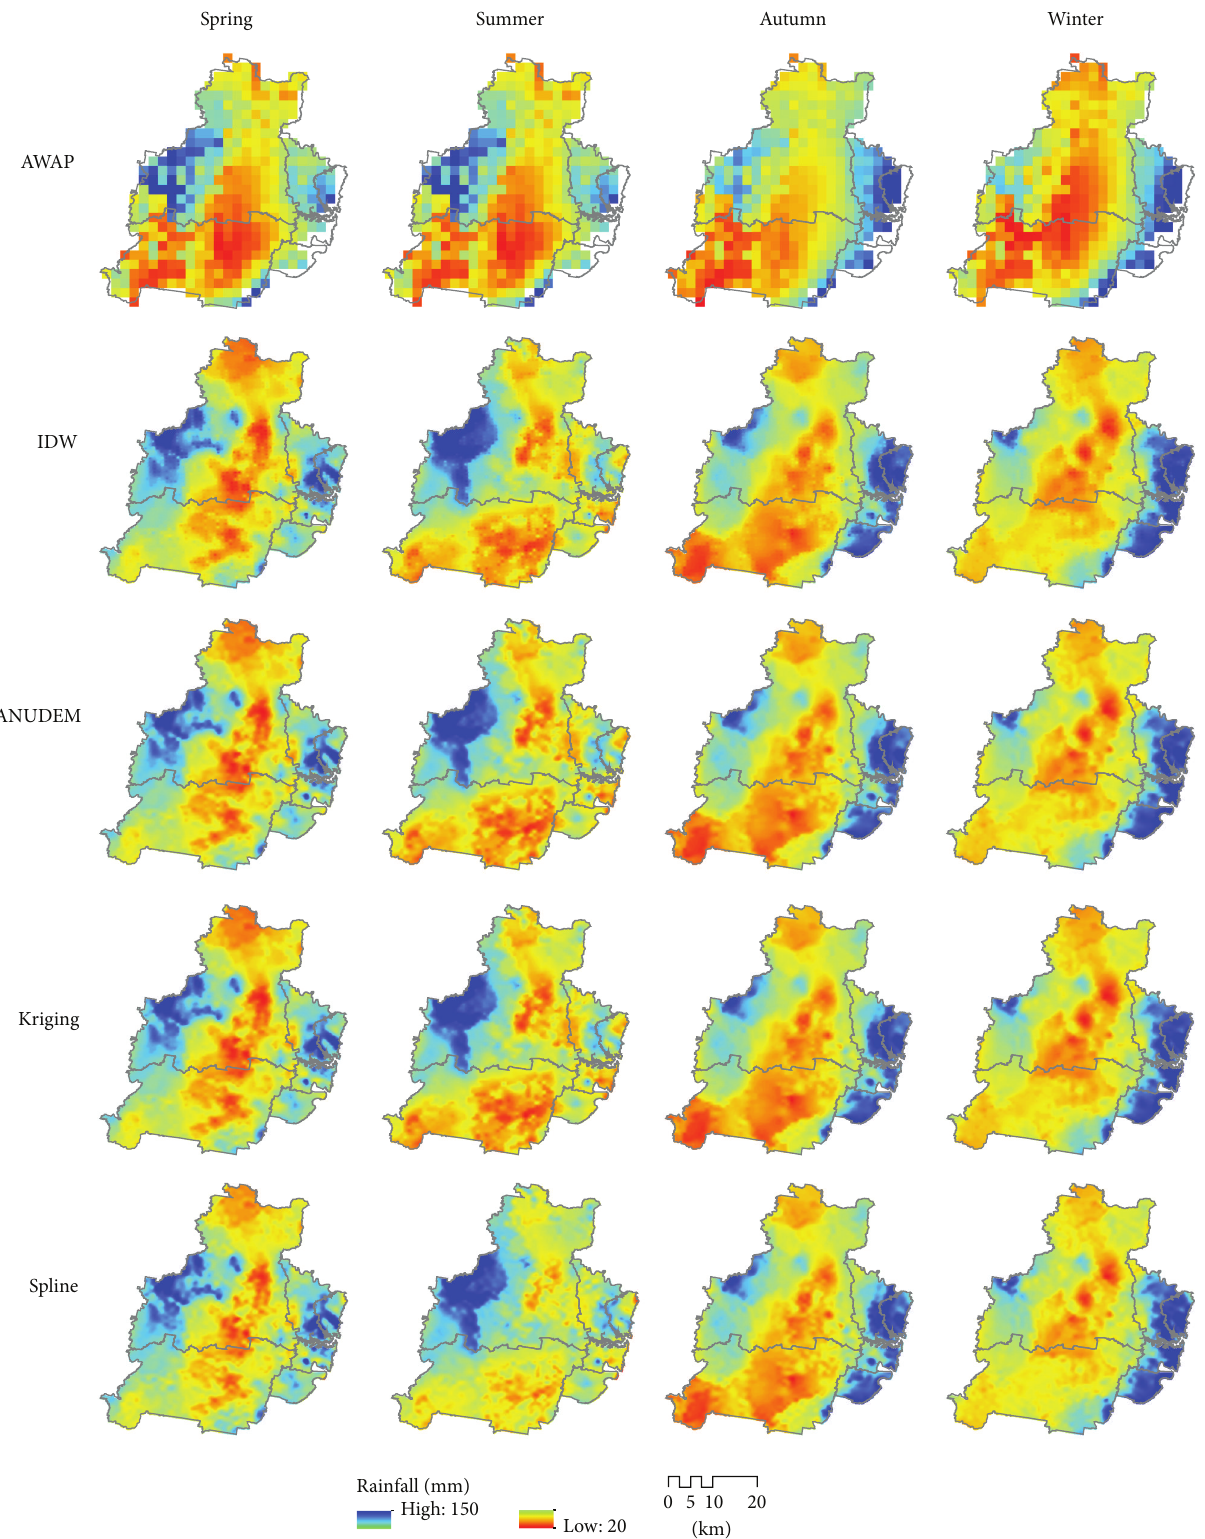
Figure 5: Comparisons of seasonal mean rainfall from AWAP and the four interpolation methods in Greater Sydney